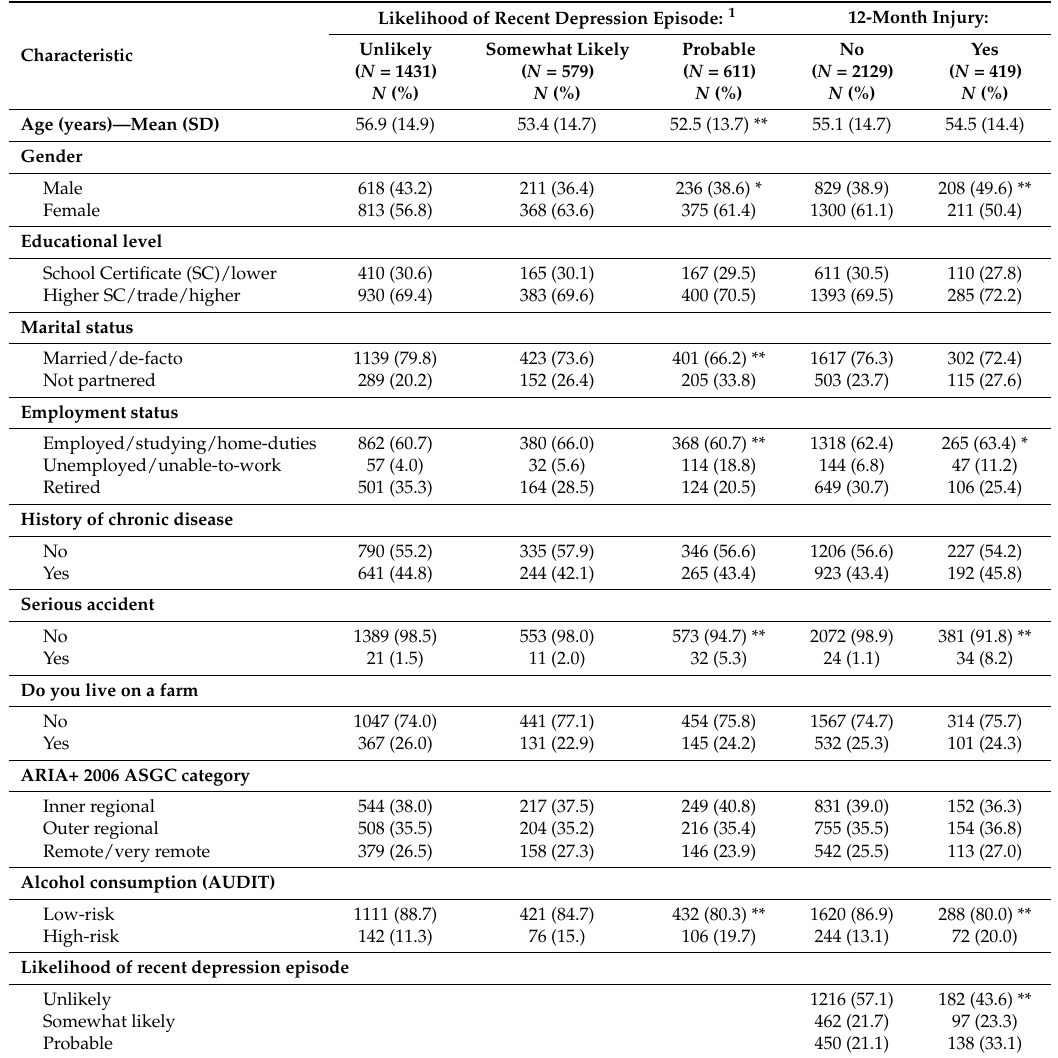
Table 1. Characteristics of Australian Rural Mental Health Study (ARMHS) participants at baseline: by likelihood of having experienced a recent depression episode, and by 12-month